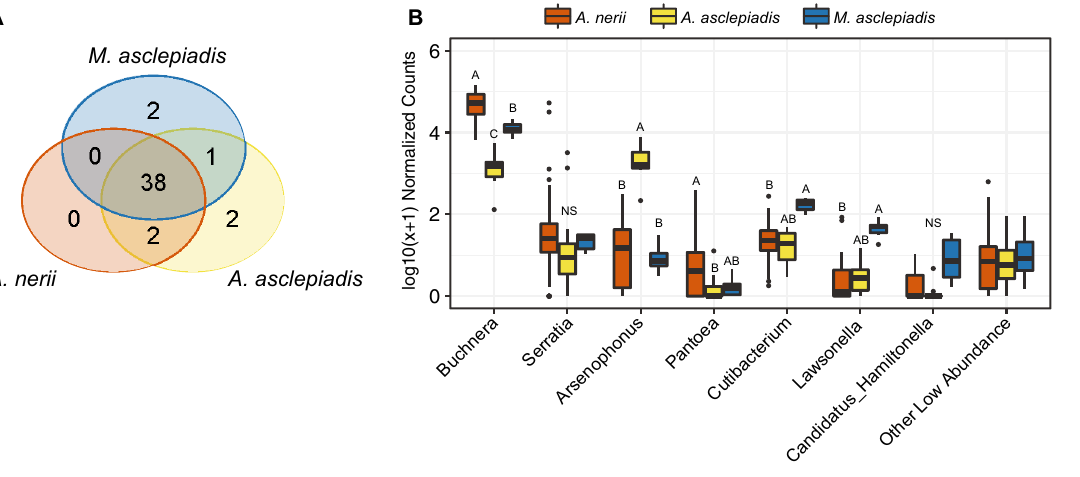
Figure 1. ( A ) Venn Diagram showing the extent to which amplicon sequence variants (ASVs) are shared and which are unique to each milkweed aphid species from samples collected across all locations. ( B ) log10(x + 1) normalized counts of bacterial taxa found across the three milkweed aphid species. If multiple strains were present they were grouped together under one genus. Very low abundant ASVs (below 1% relative abundance) were grouped together into the “Other” category, except for known aphid symbionts (i.e. Hamiltonella ) and significantly differentially abundant taxa (see Supplementary Tables S3 & S4; Supplementary Fig. S2 for details). Differing letters indicate significantly differential abundance across species by DESeq2, with an adjusted p = 0.05. NS = not significant. Figure panels generated in R and joined using Adobe Illustrator